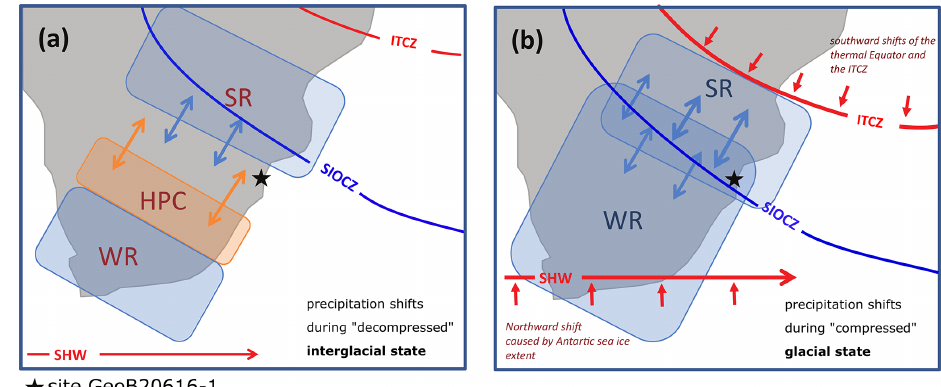
Figure 5. Conceptual model of precipitation shifts during glacial vs. interglacial (present conditions) intervals. The blue shaded boxes indicate the locations of the major regional rain-bearing systems: (i) the TTT (tropical temperate trough) moisture shifting with the SIOCZ (south Indian Ocean Convergence Zone) and bearing summer rain (therefore marked as SR); (ii) the low-pressure systems related to the SHW (southern hemispheric westerlies), bringing mainly winter rain (therefore marked as WR). The orange shaded box marks the South African high-pressure cell (HPC) shifting with the SHW. The HPC blocks SIOCZ and TTT-related moisture and therefore causes aridity. The arrows mark the millennial-scale variability of the position of these systems over the study area which is marked by a star. Please note that the millennial-scale variations that the region experiences differ in the interglacial state (a) and the glacial state (b) since the organization of the major climatic systems (marked in red) is different (“decompressed” vs. “compressed”). The conceptualization for interglacial states presented in (a) is based on a schematic model by Miller et al. (2020). In this decompressed state latitudinal shifts of the SHW indirectly control precipitation at our study site via the moisture blocking effect of the South African HPC: southward shifts of the SHW and HPC allow the SIOCZ-related TTT to bring SR to our site, whereas northward movements block this SR moisture (Miller et al., 2020). During the compressed glacial state (box B) the SHW-related WR reaches much further north, directly influencing the study site. The SR, in turn, is shifted southward, and an HPC blocking effect is not noted at our